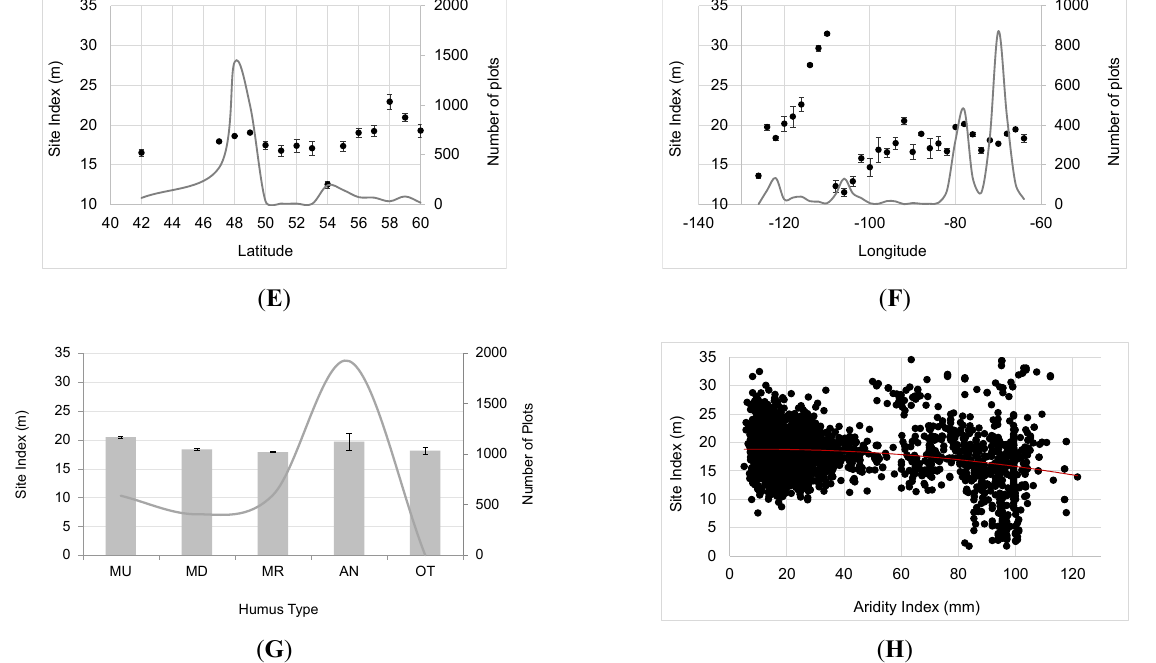
Figure 2. Variability in productivity with stand attributes ( A ) stand age, basal area proportions of ( B ) spruce and ( C ) aspen, ( D ) Shannon index and spatial elements; ( E ) latitude and ( F ) longitude and ( G ) humus type ( H ) aridity index (mm). Red line denotes linear or quadratic fits and grey lines refer to the number of plots under each x-category. Error bars denote standard